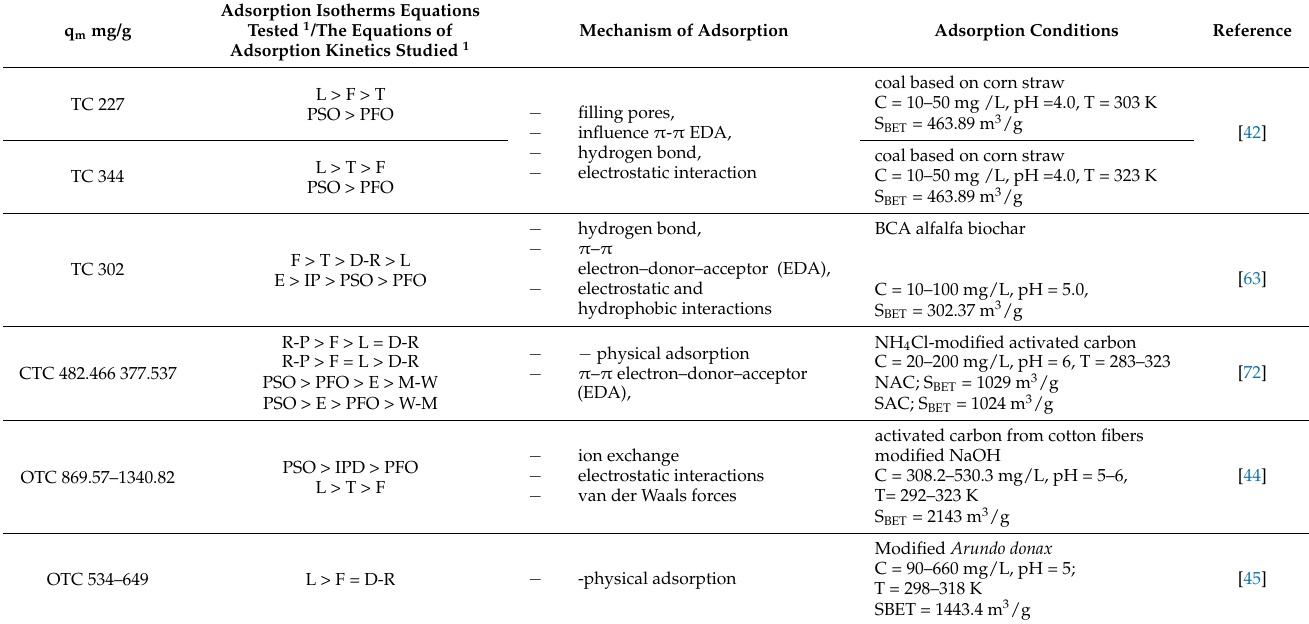
Table 13. Comparison of tetracycline adsorption results based on literature